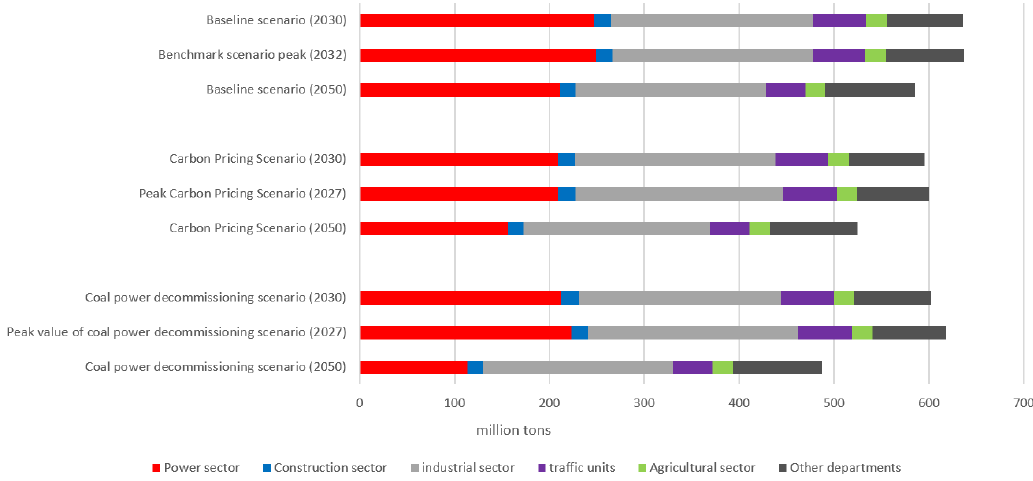
Figure 14. Comparison of CO 2 emissions in Zhejiang Province under three scenarios.